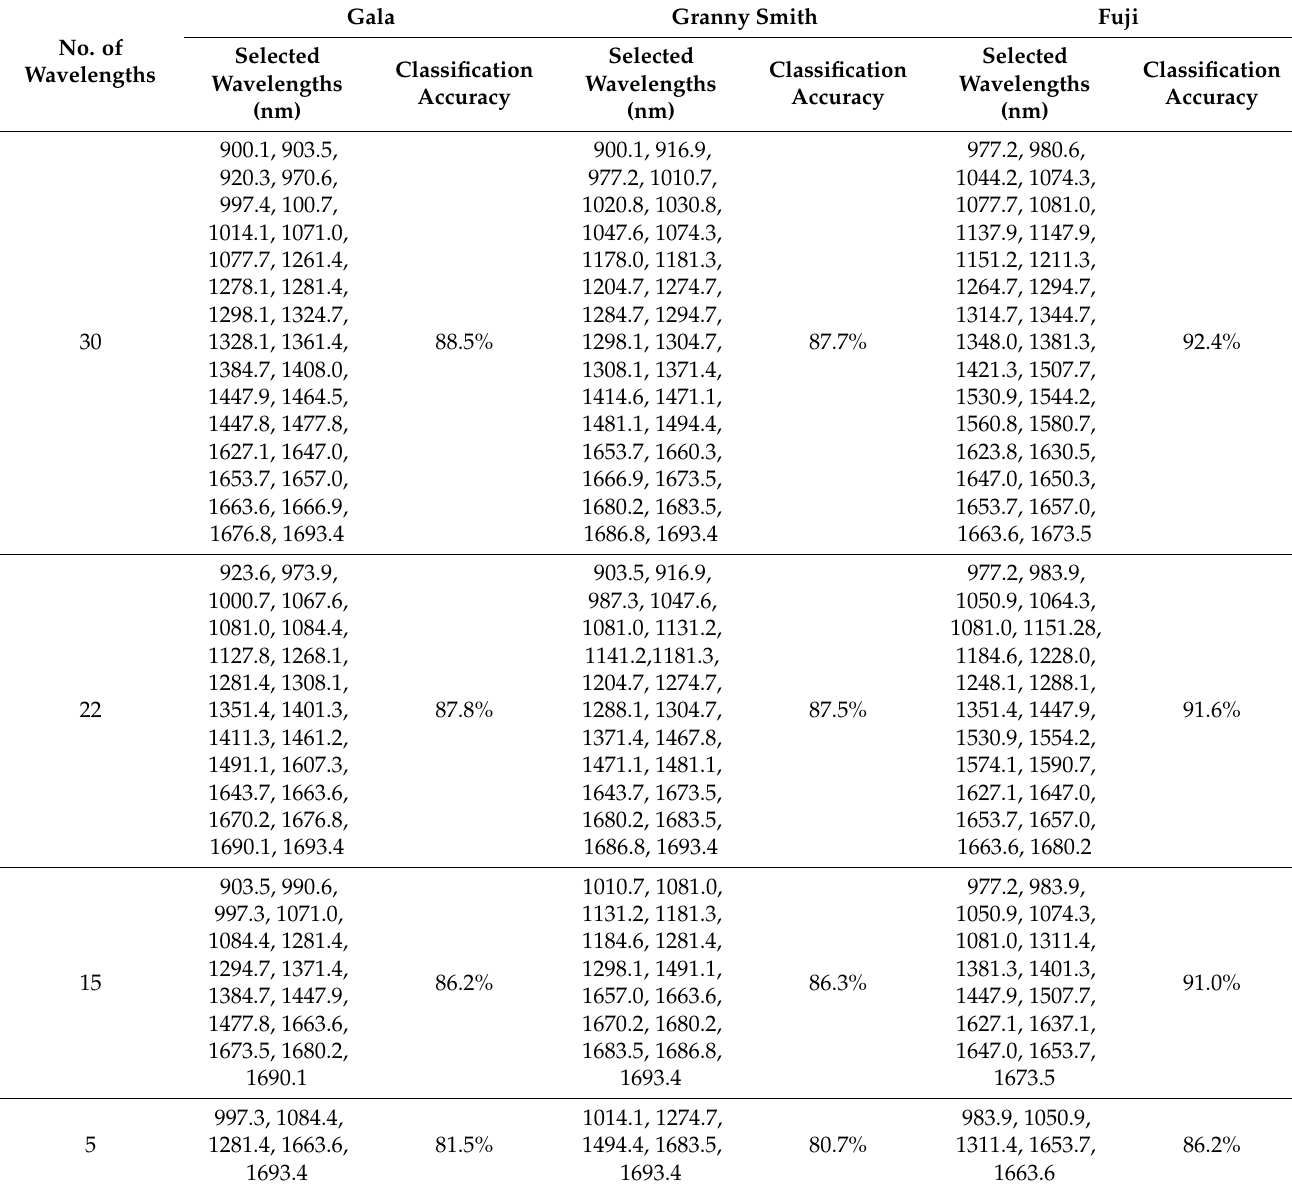
Table 5. Classification performance of selected optimal